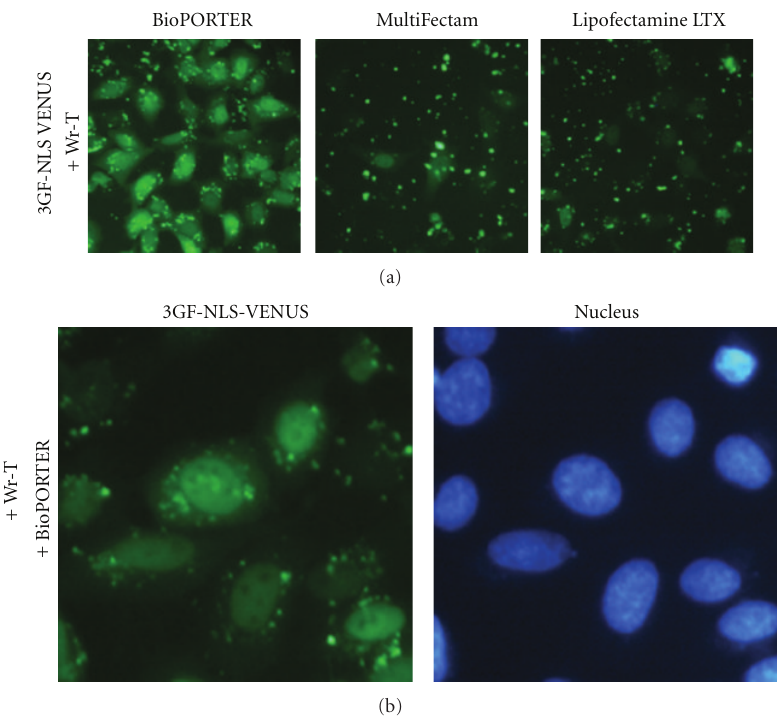
Figure 3: Wr-T/cationic lipid reagents mixture-mediated selective delivery of proteins into living cells. (a) 3 (cid:3) GST and FLAG tag-NLS VENUS proteins were incubated with Wr-T and cationic lipid reagents and then overlaid onto HeLa cells in serum-free medium for 3 h. The cells were then washed and observed at the same exposure time by fluorescence microscopy. (b) The cells treated with Wr-T/BioPORTER mixture were counterstained with Hoescht